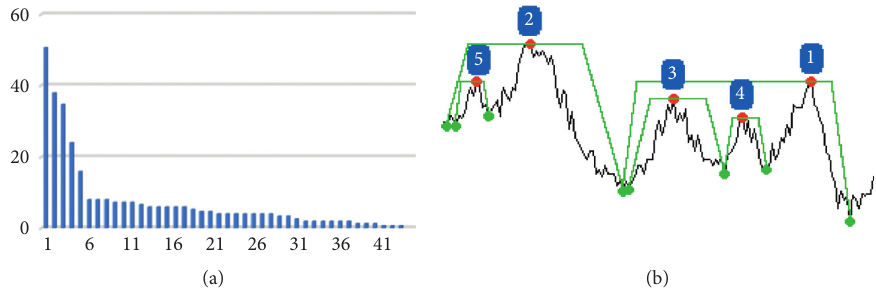
Figure 10: (a) Sorted prominences of Road2 data, where the ratio of the 5th (the prominence of the last detected peak) to the 6th (the greatest prominence of the noise) is 201%. (b) The detected peak points (each marked by its prominence ordinal number) and the supporting